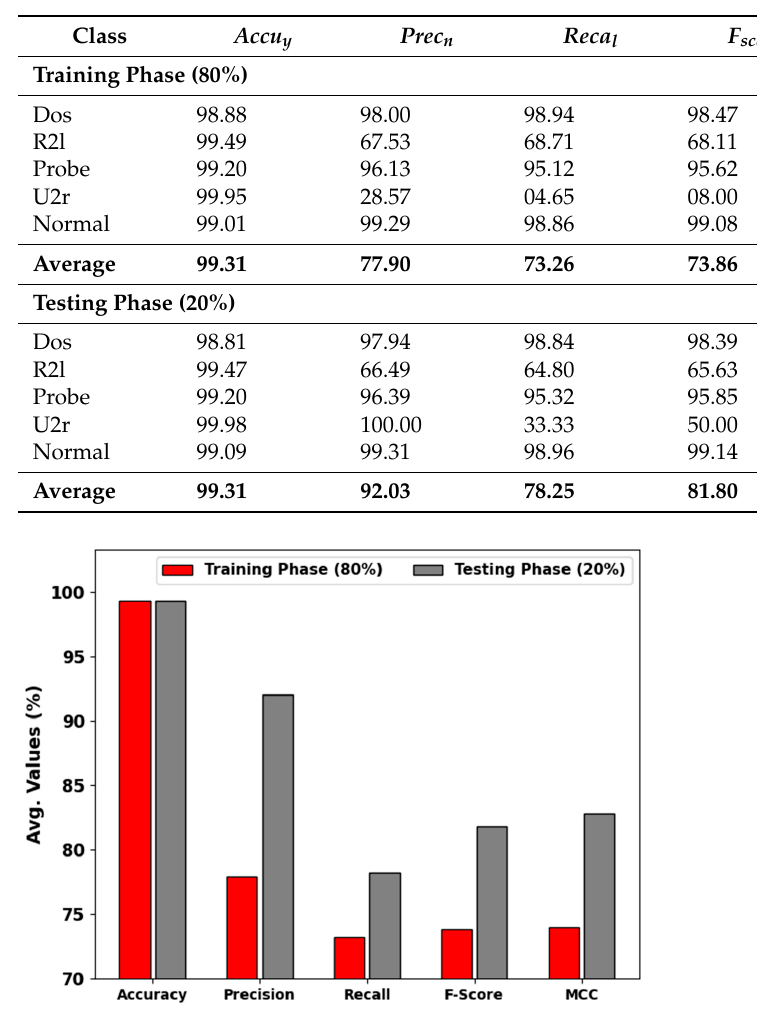
Table 2. Result analysis of IMFL-IDSCS system under 80:20 of TR/TS databases.